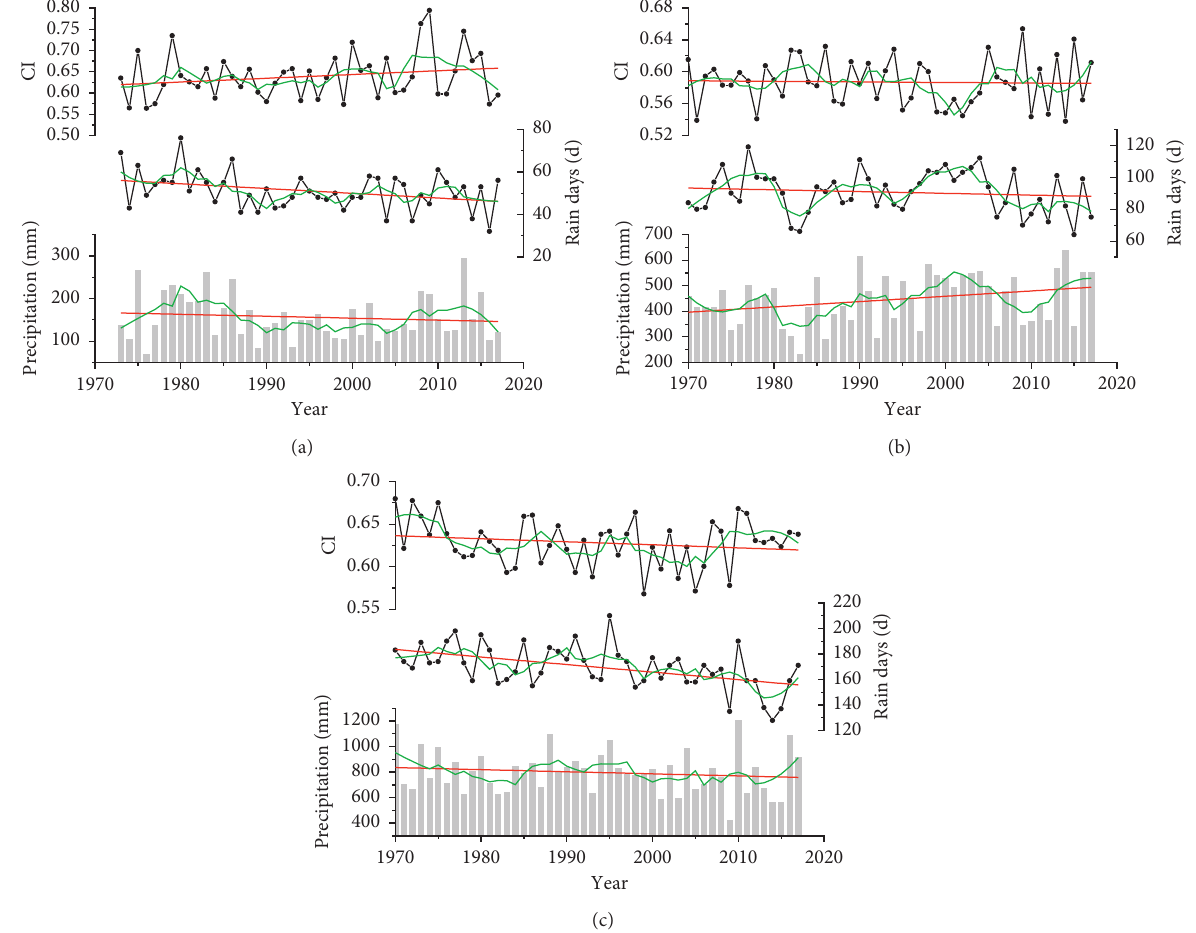
Figure 5: Time series of annual CI, rainy days, and total precipitation amount at the Pulan (a), Lasa (b), and Chayu stations (c). The solid red lines are the corresponding linear trend and the solid green line is 9-year smooth line.